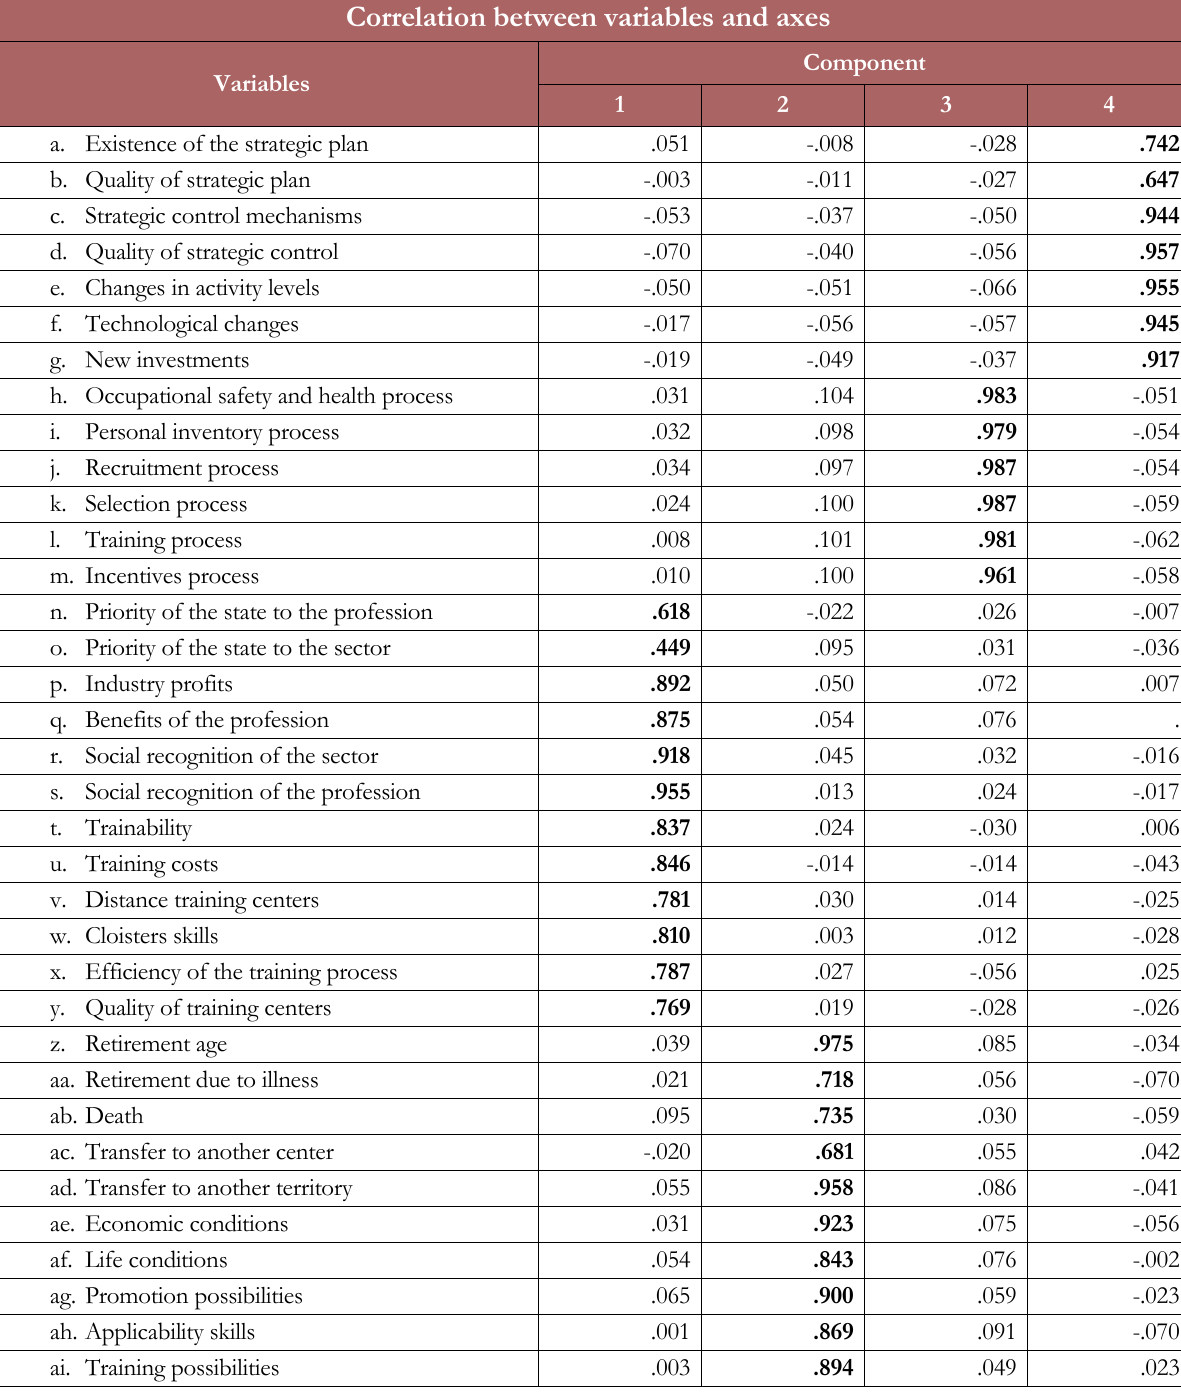
Table 2. Results of correspondence analysis for HRP at national